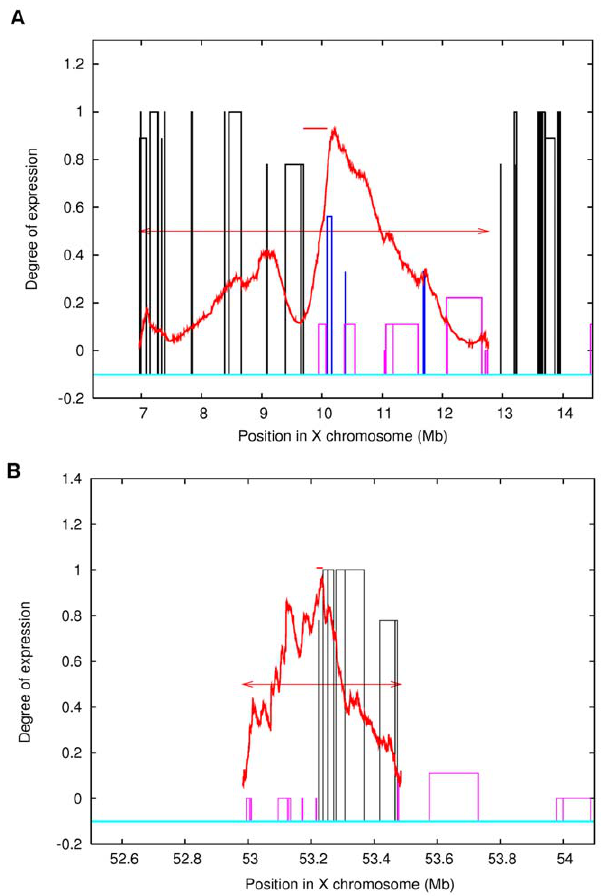
Figure6.JSdivergenceplotsofdomainpairs. FiguresAandBdisplay the compositional variation in two sample domain pairs 1 & IX listed in Table 2. The arrows show the location of domains in the pair. The vertical bars are the normalised gene expression of the genes in these regions. The segmentation boundaries coincide with regions having differential gene expression. The divergence maximum occurs near a known boundary are suggestive of high compositional differences between these domains.